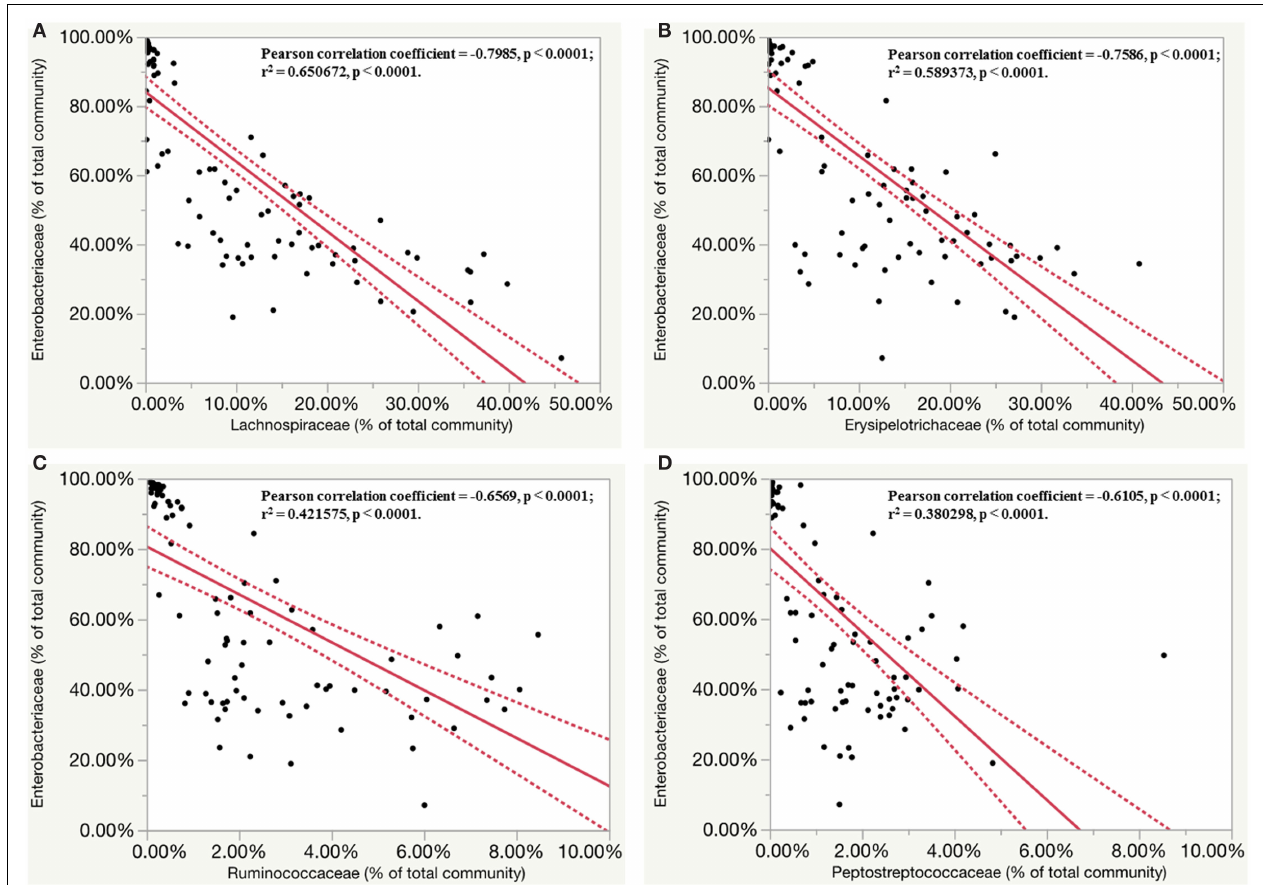
FIGURE 7 | Inverse correlation between relative abundance of members of Enterobacteriaceae family with other four major family groups . Dashed line indicated 95% confidence intervals. (A) Linear regression plots of relative abundance of bacteria (% of total community) belonging to Enterobacteriaceae family and Lachnospiraceae family in S. Enteritidis-infected group. (B) Linear regression plots of relative abundance of bacteria belonging to Enterobacteriaceae family and Erysipelotrichaceae family in S. Enteritidis-infected group. (C) Linear regression plots of relative abundance of bacteria belonging to Enterobacteriaceae family and Ruminococcaceae family in S. Enteritidis-infected group. (D) Linear regression plots of relative abundance of bacteria belonging to Enterobacteriaceae family and Peptostreptococcaceae family in S. Enteritidis-infected